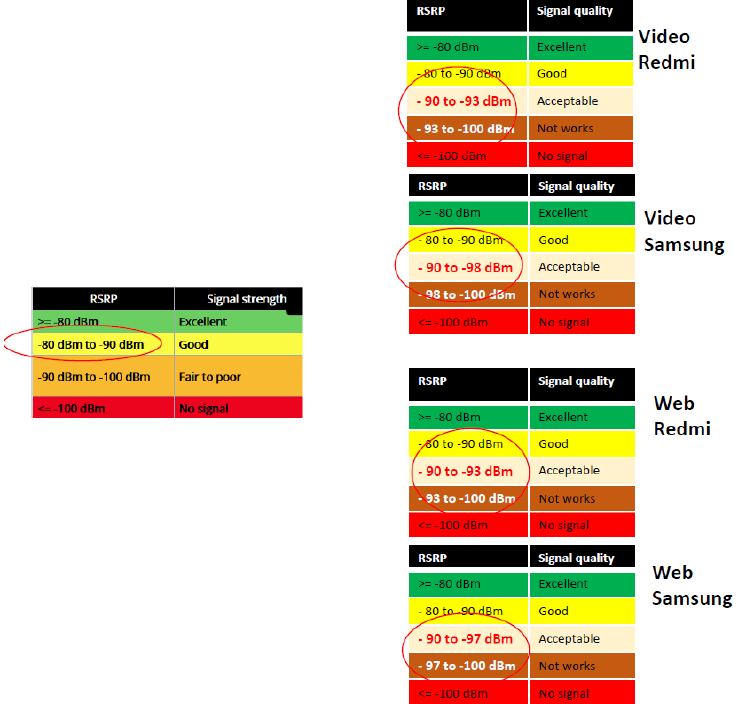
Figure 7. Recommended RSRP signal strength levels by service (web or video) and by device used (Redmi or